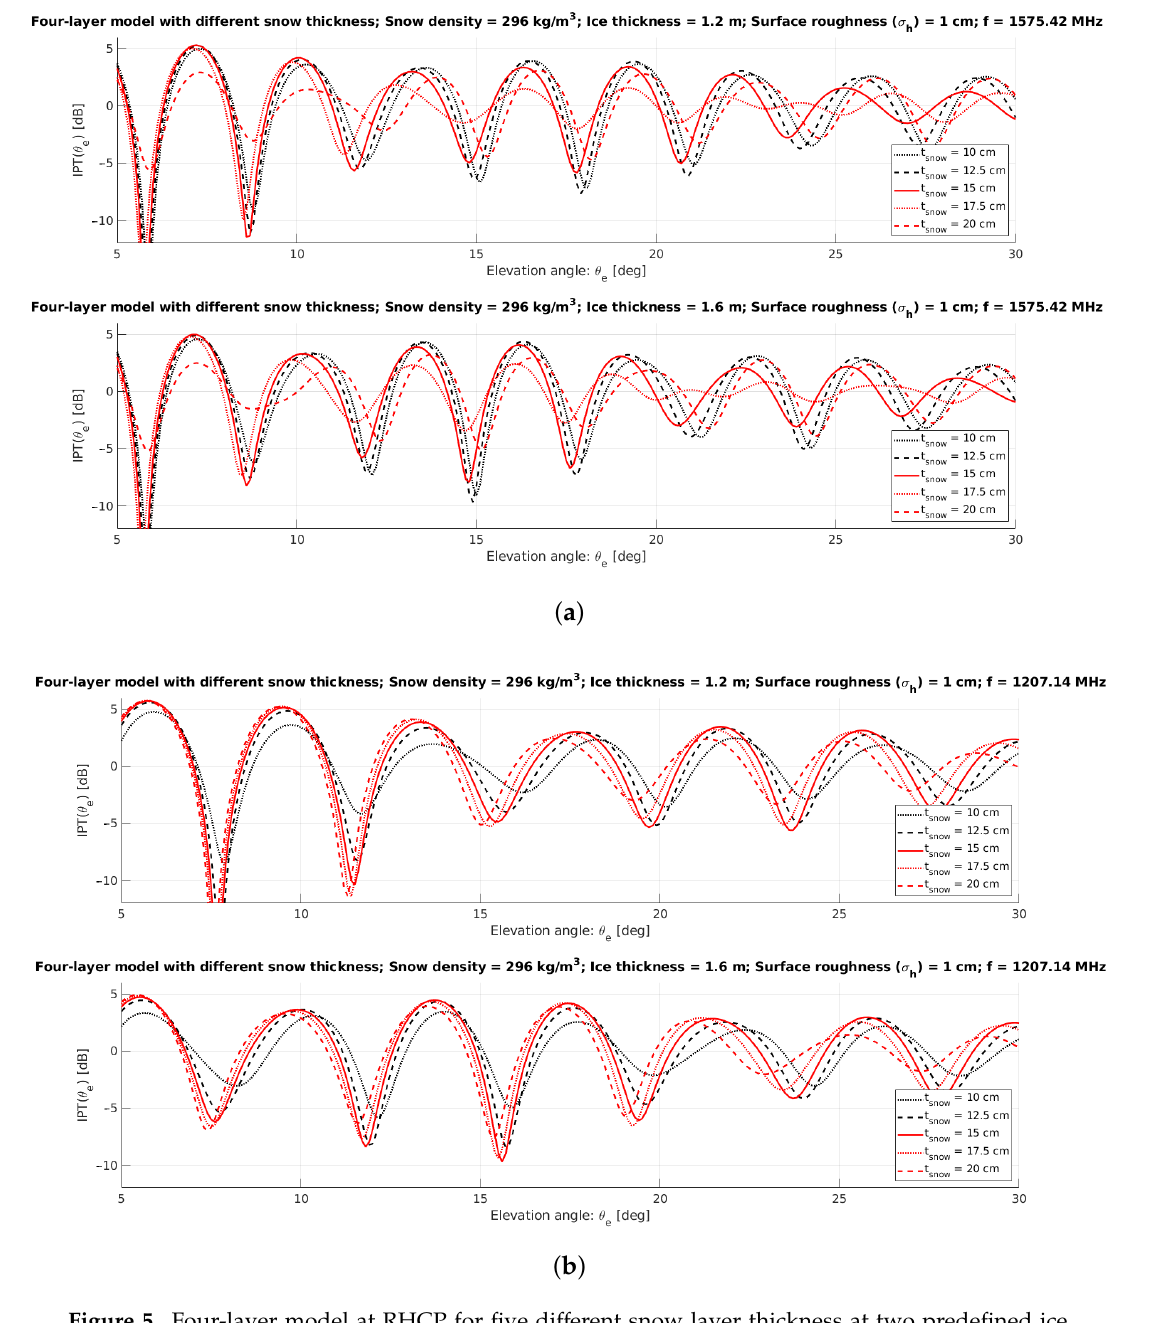
Figure 5. Four-layer model at RHCP for five different snow layer thickness at two predefined ice thickness, ( top ) 1.2 m, and ( bottom ) 1.6 m. Simulation at 1575.42 MHz ( a ) and 1207.14 MHz ( b ). Assuming a surface roughness between layers of 1 cm.